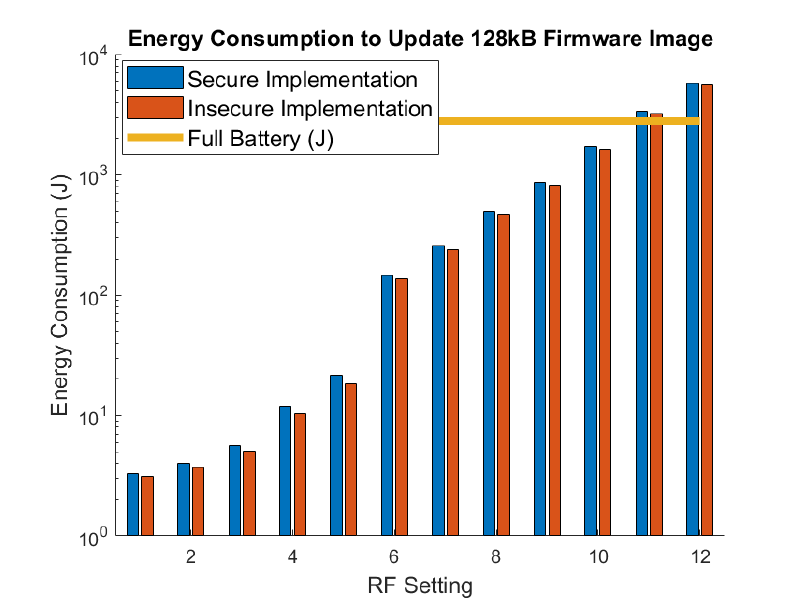
Figure 8. The energy consumption required to update a 128 kB firmware image.